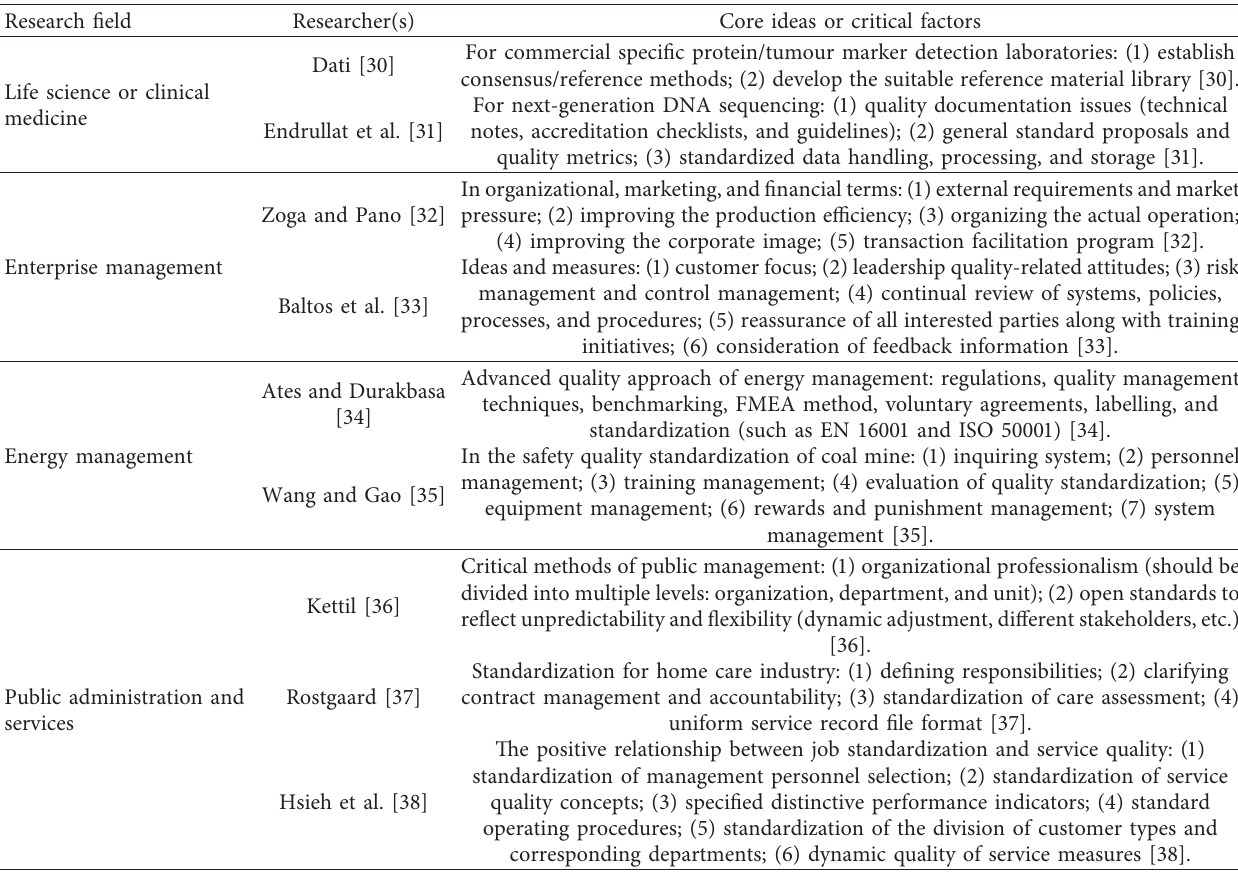
Table 1: Research on quality management standardization in different